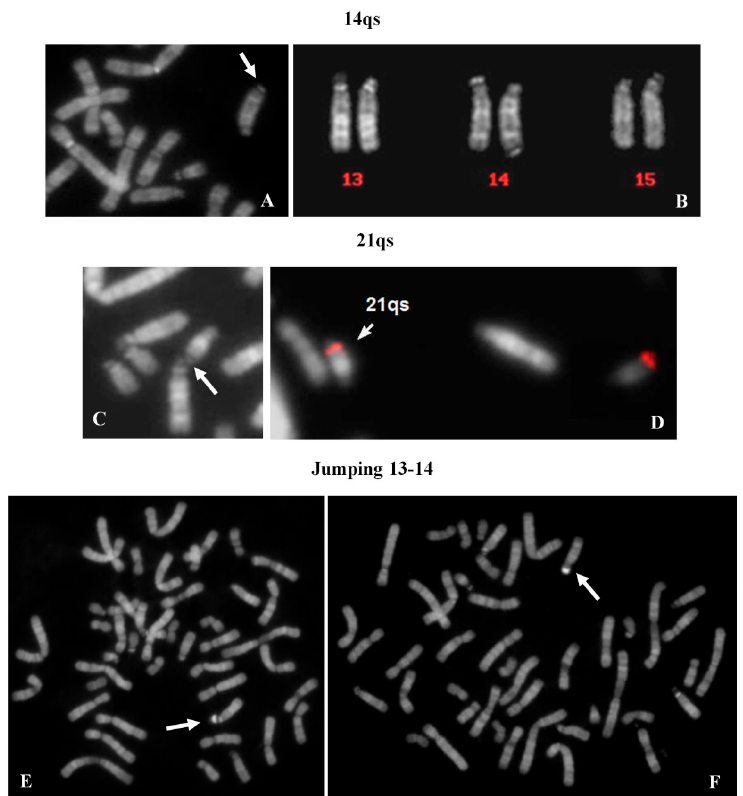
Figure 5. 14qs: ( A ) partial metaphase showing the 14qs (arrow); ( B ) chromosomes 13, 14 and 15: one chromosome 14 showed the cytological satellite on q arm. 21qs: ( C ) partial metaphase showing the 21qs (arrow) in association with chr 14; ( D ) specific subtelomeric probes of 21q hybridized both chromosomes 21. Satellite jumping: metaphases showing the satellite jumping between ( E ) chromosome 13 and ( F ) chromosome 14. All images were captured at 100× magnification (see materials and methods for details).